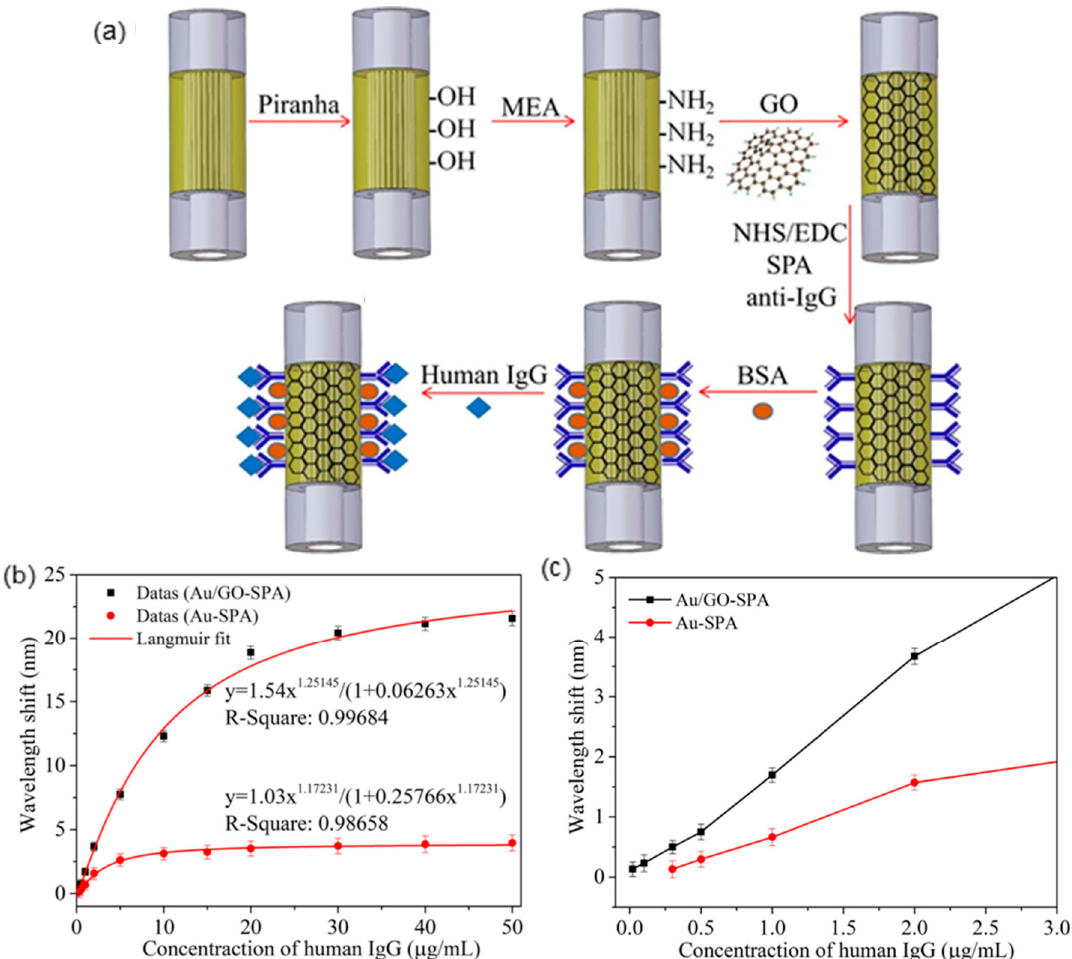
Figure 7. ( a ) Fabrication of graphene oxide (GO)-modified SPR immunosensor. ( b ) Fitting curve of wavelength shift versus human IgG concentration. ( c ) Local enlarged drawing (Figure adapted with permission from reference [44]).